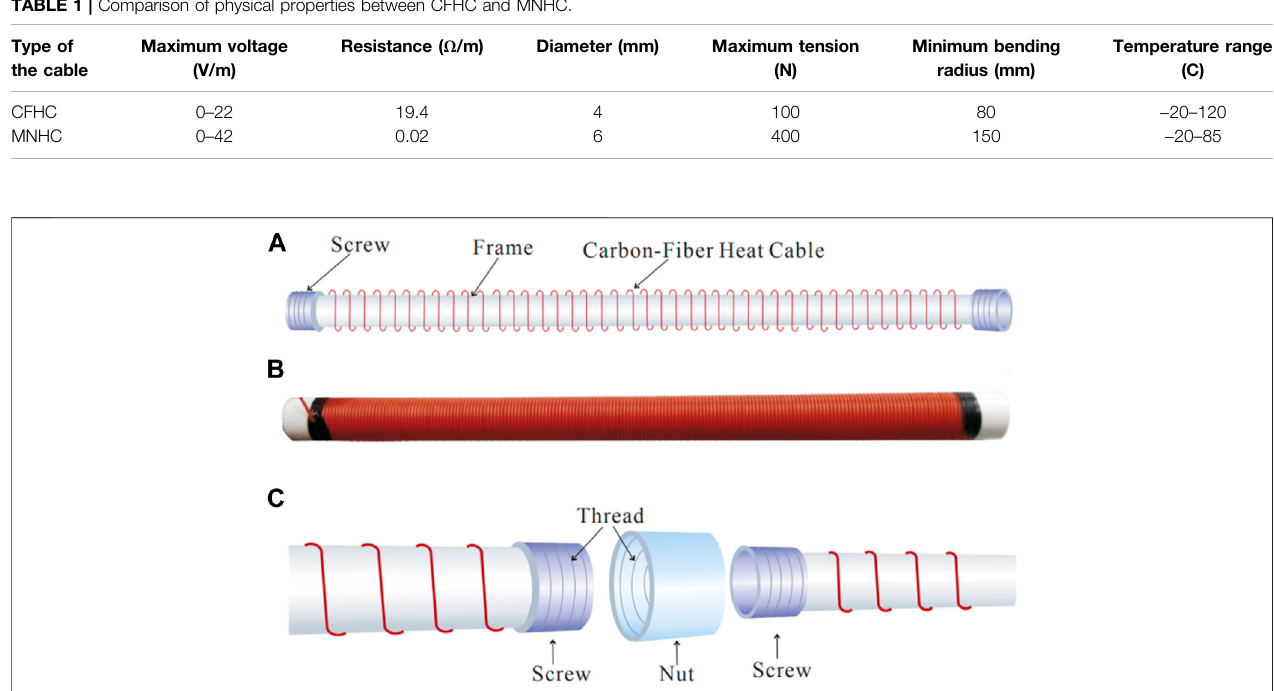
FIGURE 4 | Schematic diagram of CFHST. (A) CFHST structure. (B) Photo of the CFHST. (C) Screwed-on connection of the CFHST (Cao et al., 2018a).